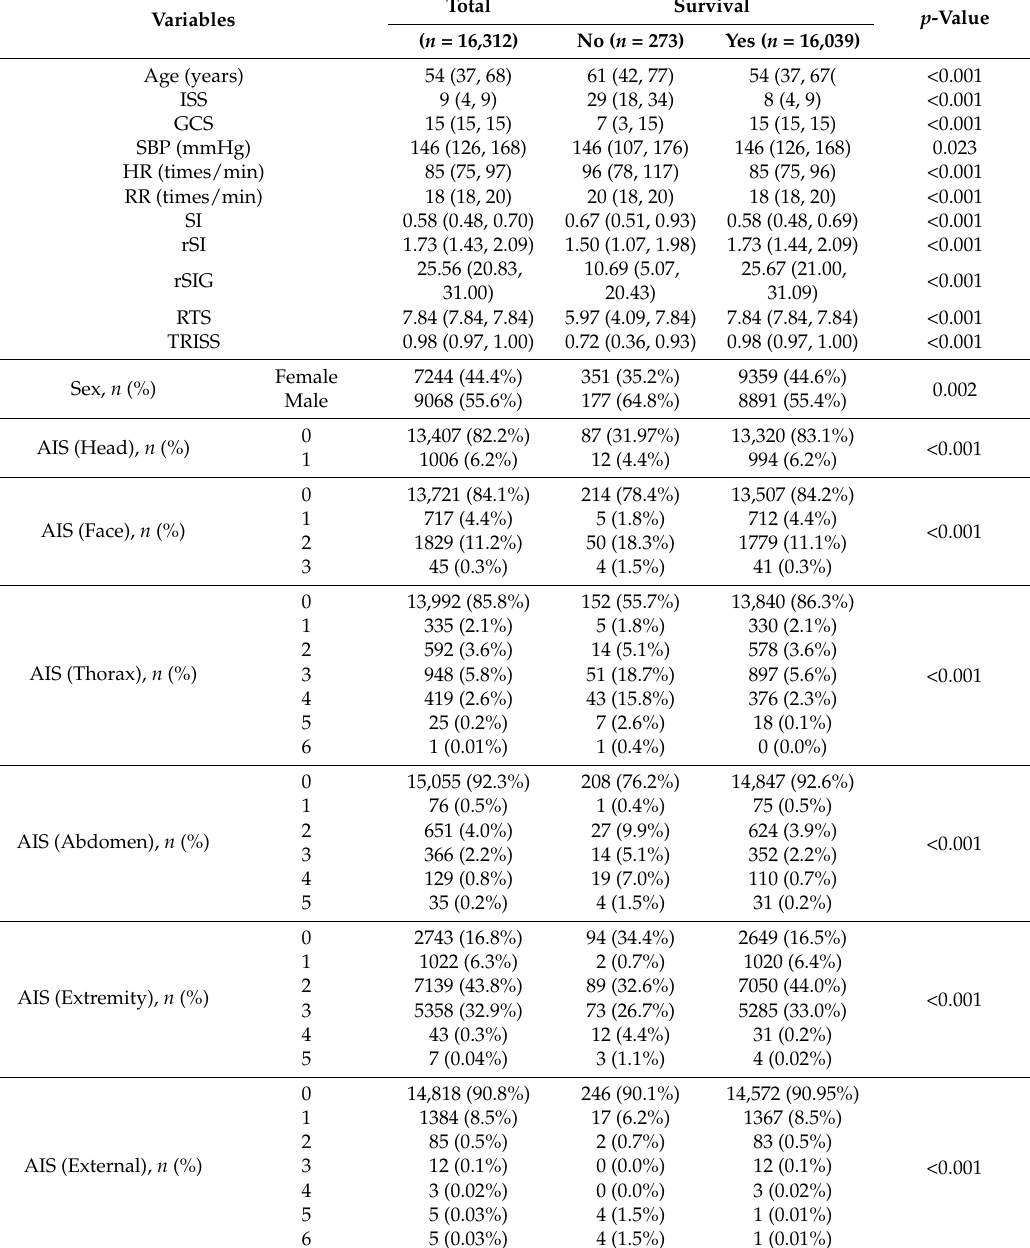
Table 3. Characteristics variables of patients without head